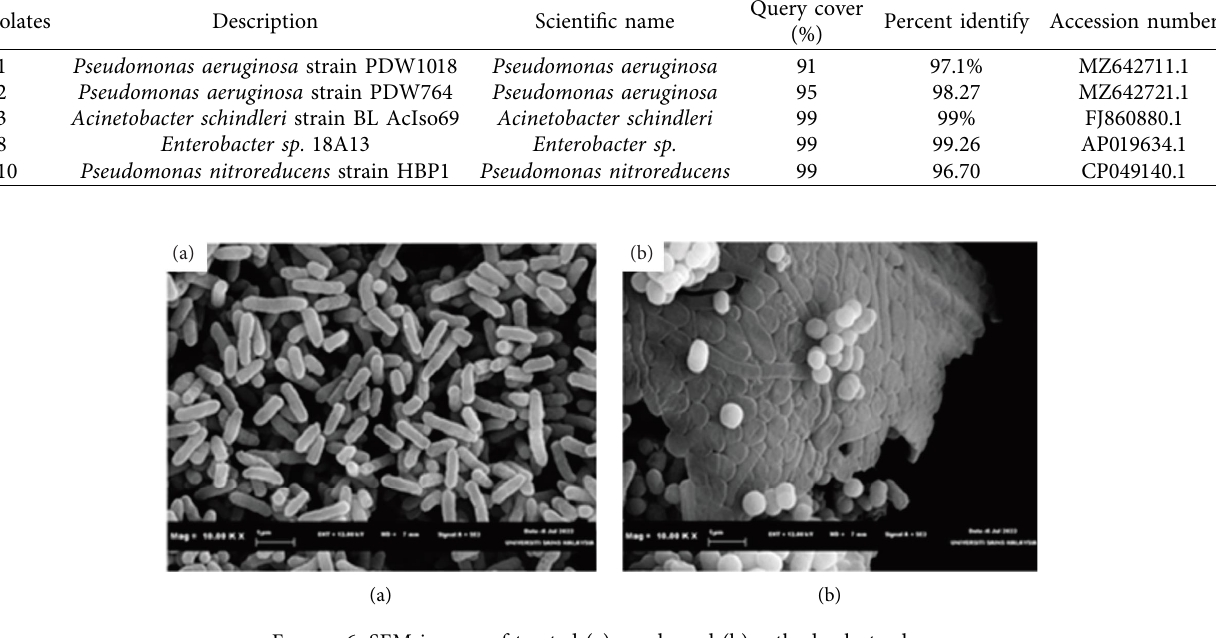
Figure 6: SEM images of treated (a) anode and (b) cathode